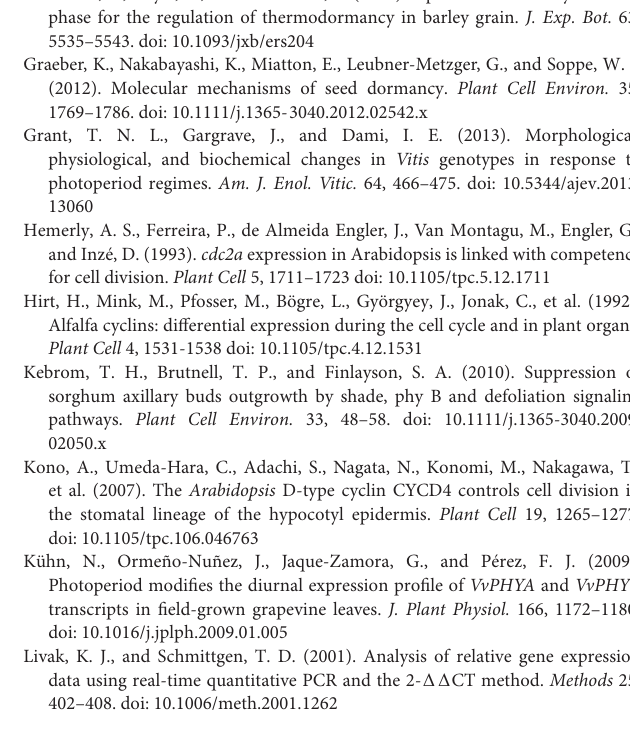
FIGURE S1 | Effect of ABA on the expression of (A) cyclin-dependent kinases ( VvCDKs ), (B) cyclins ( VvCYCs ), and (C) inhibitors of CDKs ( VvICKs ) on the shoot-apex of Thompson seedless grapevines. Gene expression analysis was performed by RT-qPCR and normalized against VvACTIN . Values are the average of three biological replicates with three technical